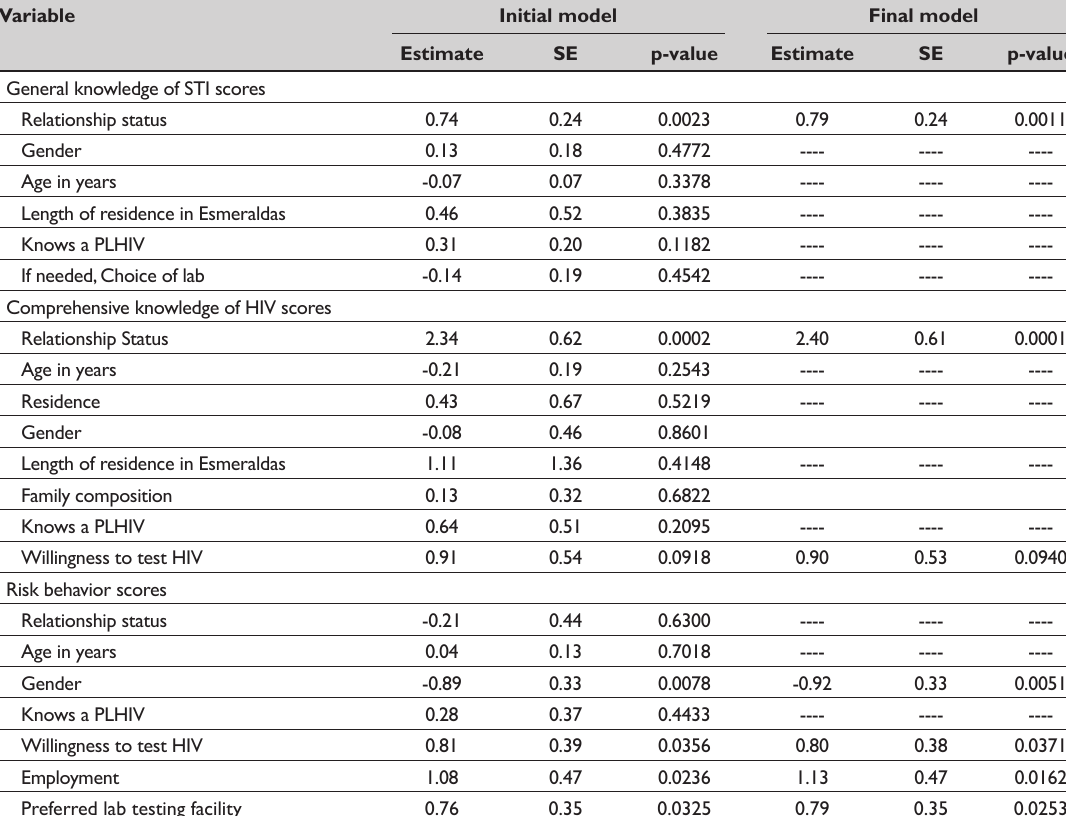
Table 4: Determinants of general knowledge of sexually transmitted infections (STI) scores, comprehensive knowledge of HIV scores and risk behavior scores among school-attending afro-descendant